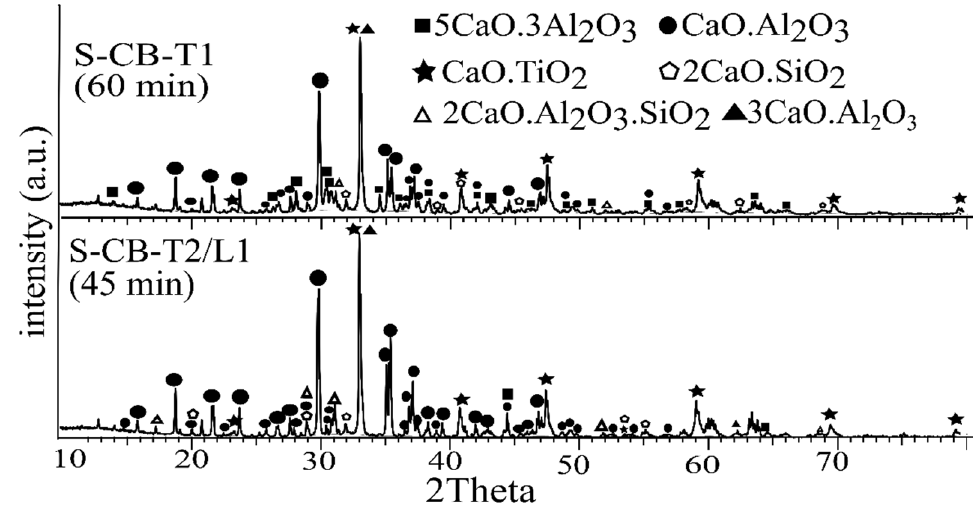
Figure 8. XRD analysis of the slags at different durations.